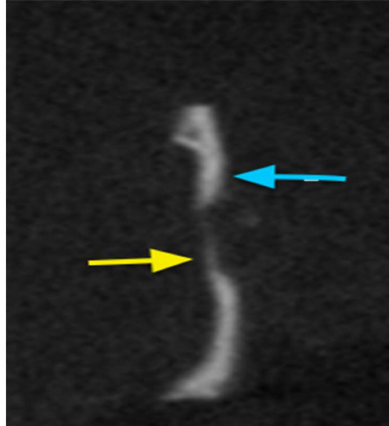
Figure 12. Sagittal view for cone beam computed tomography (CBCT) for the coated PE disc in situ after three months. The area of bone regeneration is shown by the yellow arrow, while the area of native bone is shown by the blue arrow. The area of the PE graft appears